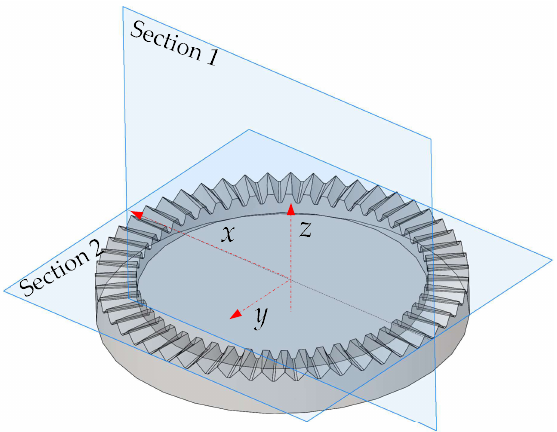
Figure 6. Description of Sections 1 and 2.